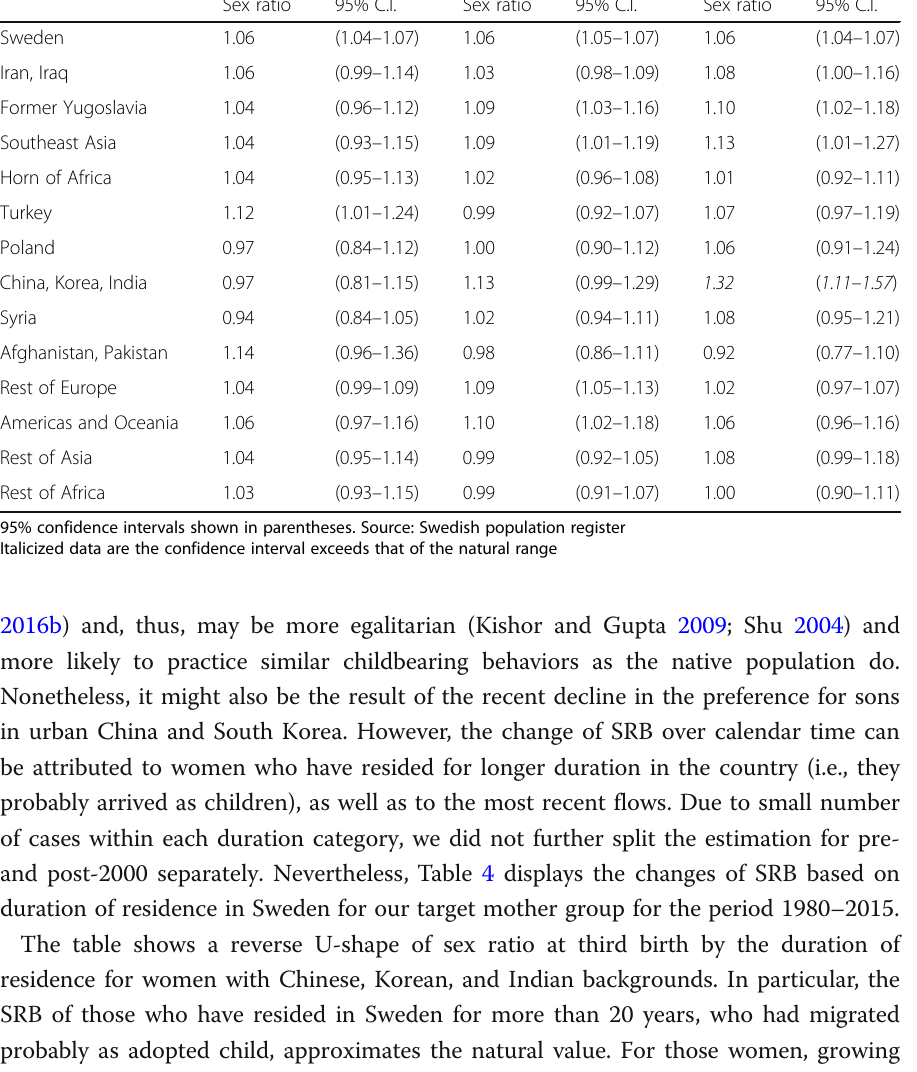
Table 3 Sex ratio at birth, 3rd births, by sex of previous children, and country/region of birth of the mother: Sweden, 1980 – 2015